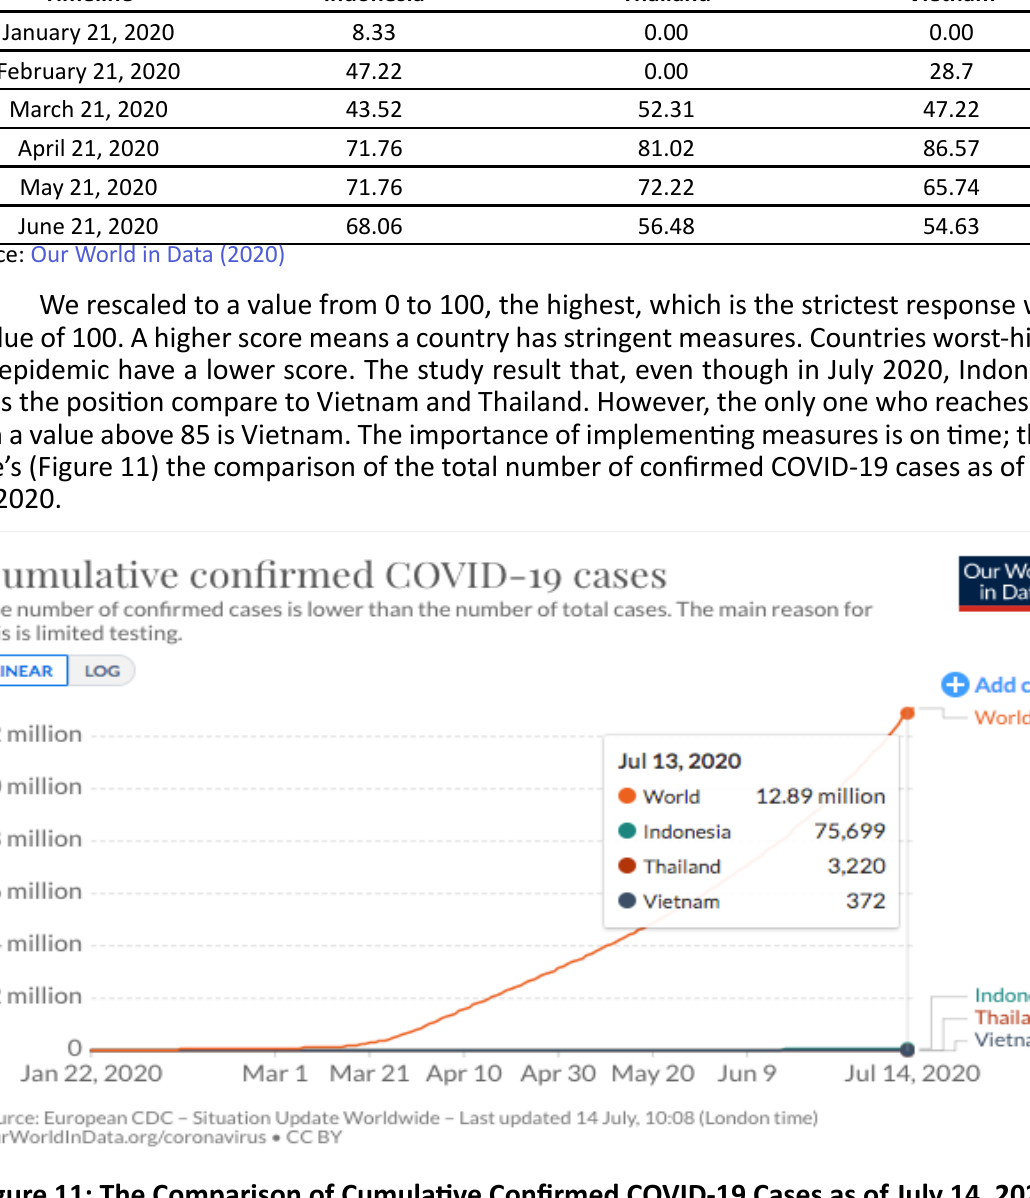
Figure 11: The Comparison of Cumulative Confirmed COVID-19 Cases as of July 14, 2020 Source : European CDC